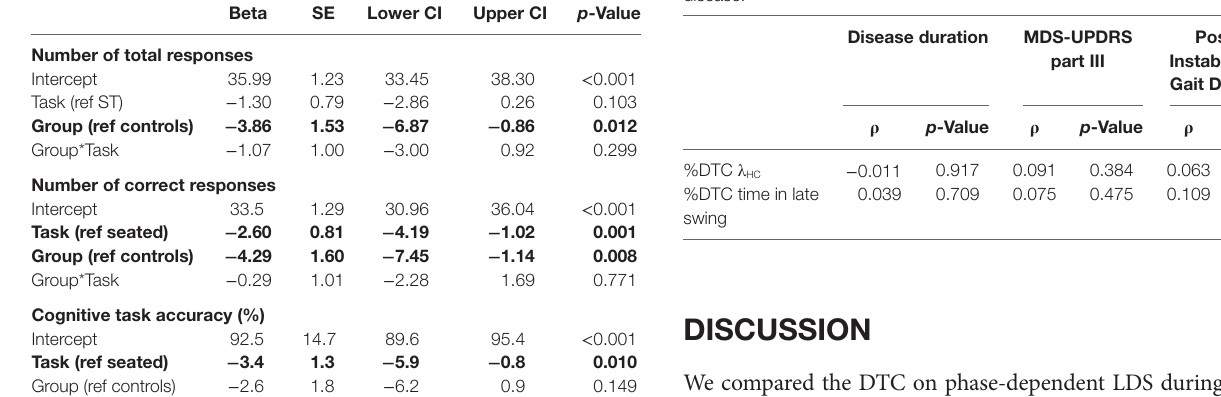
Table 6 | Spearman correlation coefficients and p -values for comparisons between the %DTC of λ HC and clinical characteristics in subjects with Parkinson’s